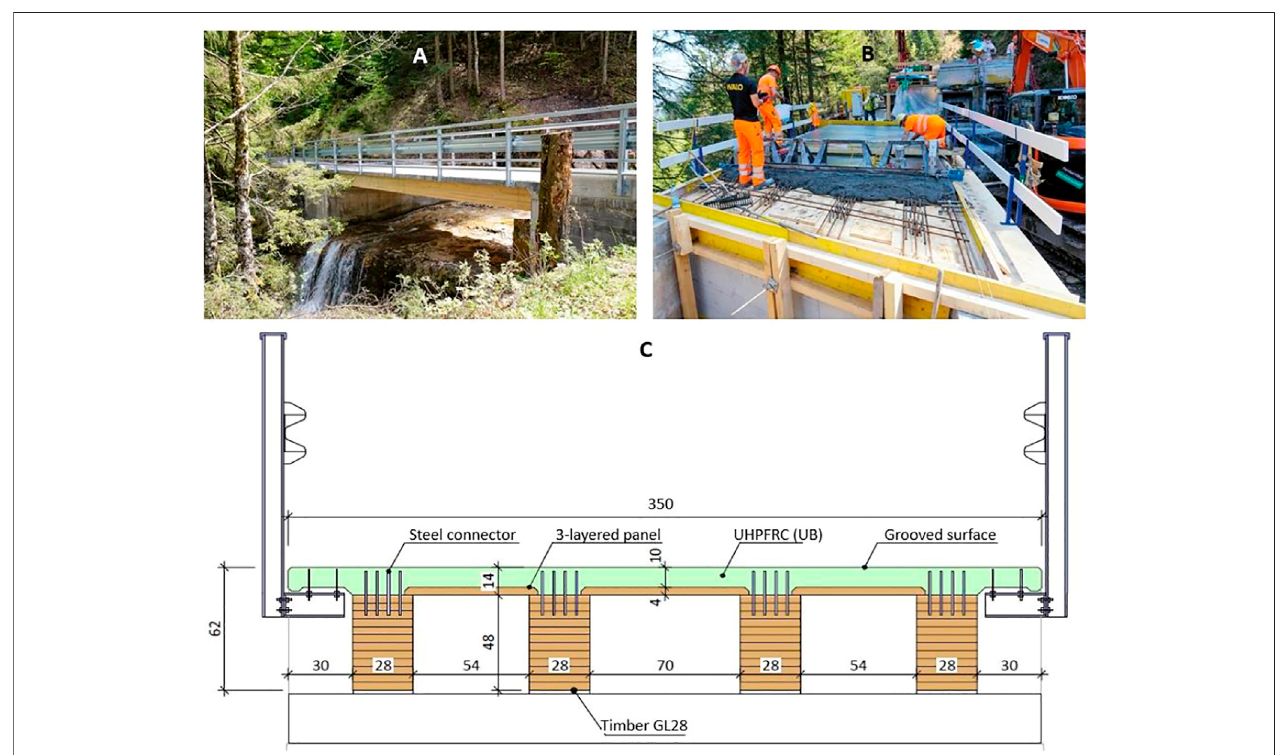
FIGURE15| FruttliBridge. (A) Photographofthebridge; (B) pouringoftheUHPFRCdeck. (C) sectionofthecompositetimber-UHPFRCbridge.(Photographs: E. Kälin).